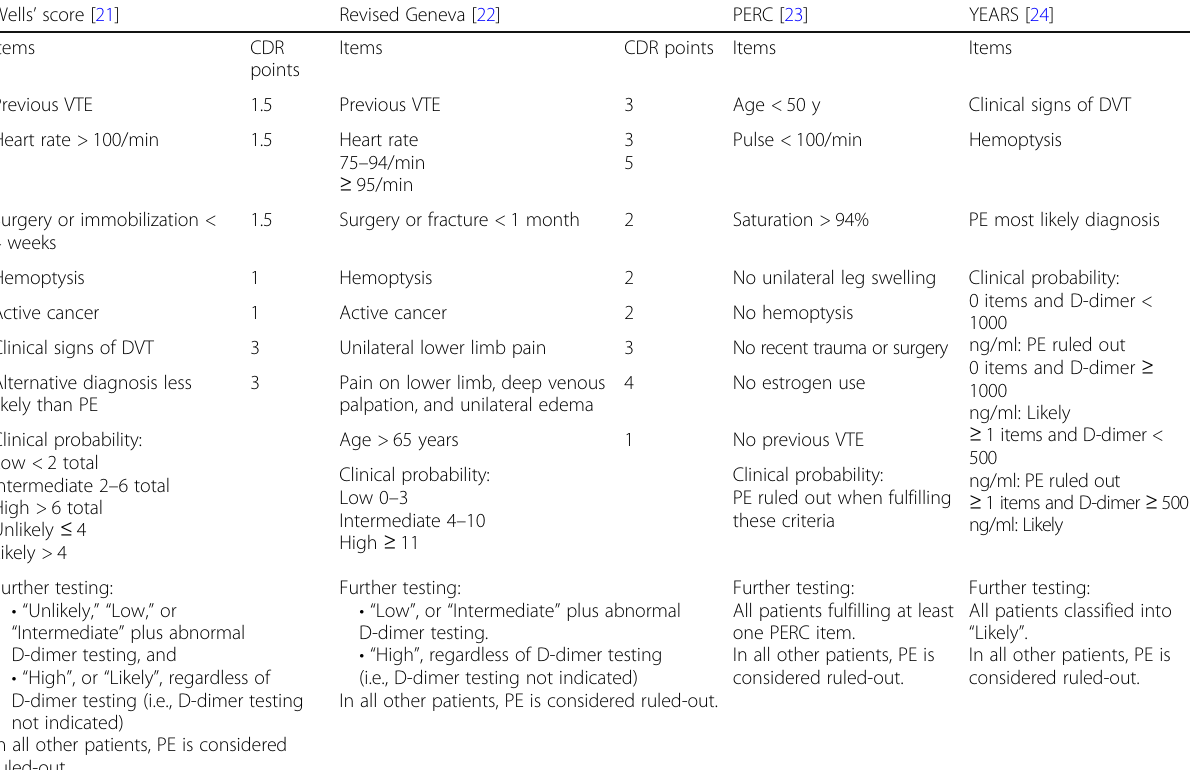
Table 1 Clinical decision rules under